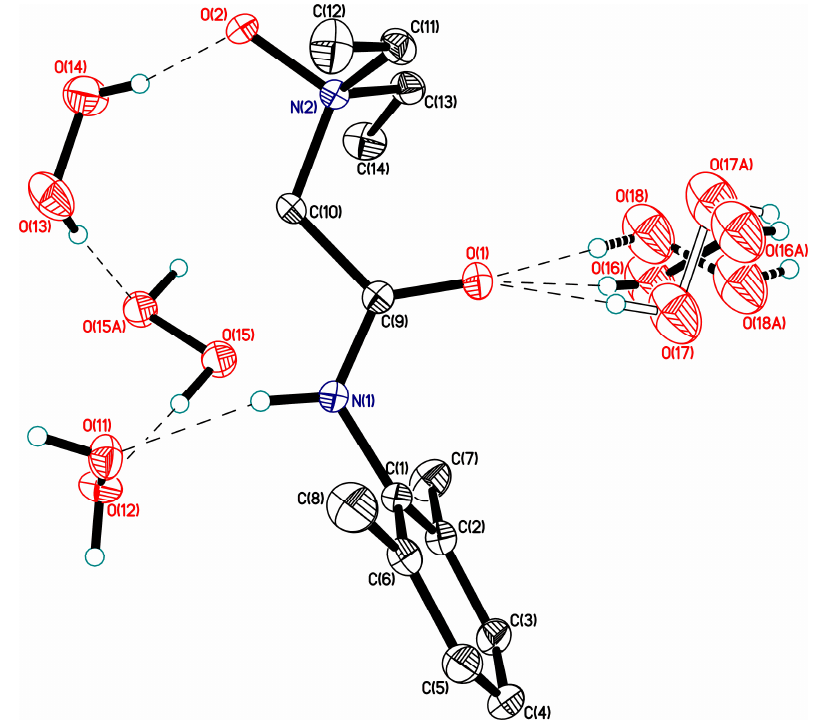
Figure 11. Neutral H-bonds between the NH group and hydrogen peroxide in the crystal of the peroxosolvate lidocaine N-oxide C 14 H 22 N 2 O 2 · 3H 2 O 2 . H-bonds are given by dotted lines. Reprinted with permission from the authors of [85]. Copyright 2017 WileyVCH Verlag GmbH & Co. KGaA.